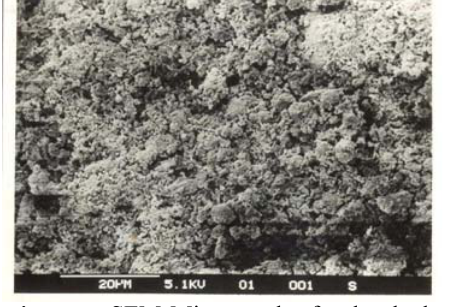
Figure 8. SEM Micrograph of unleached LFAS composite containing nickel hydroxide sludge